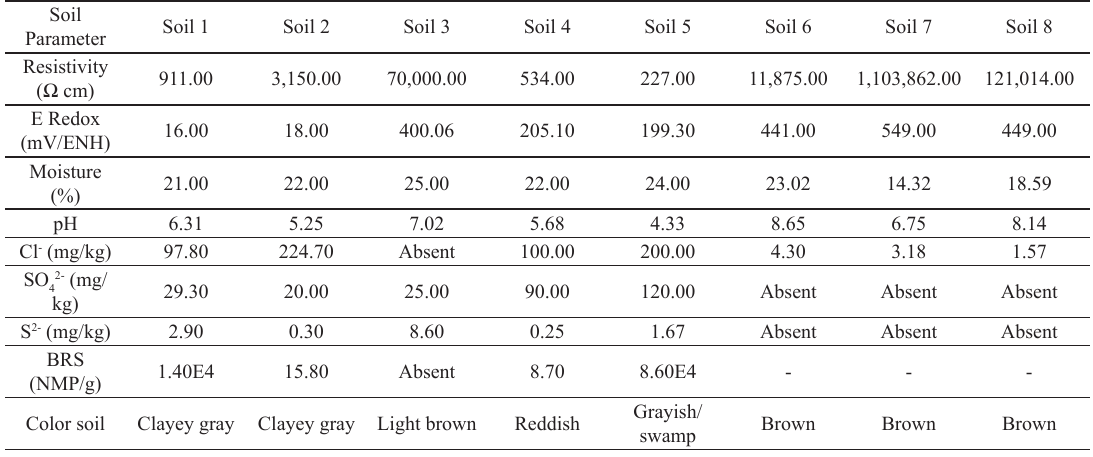
Table 4. Physical chemical and bacteriological parameters of